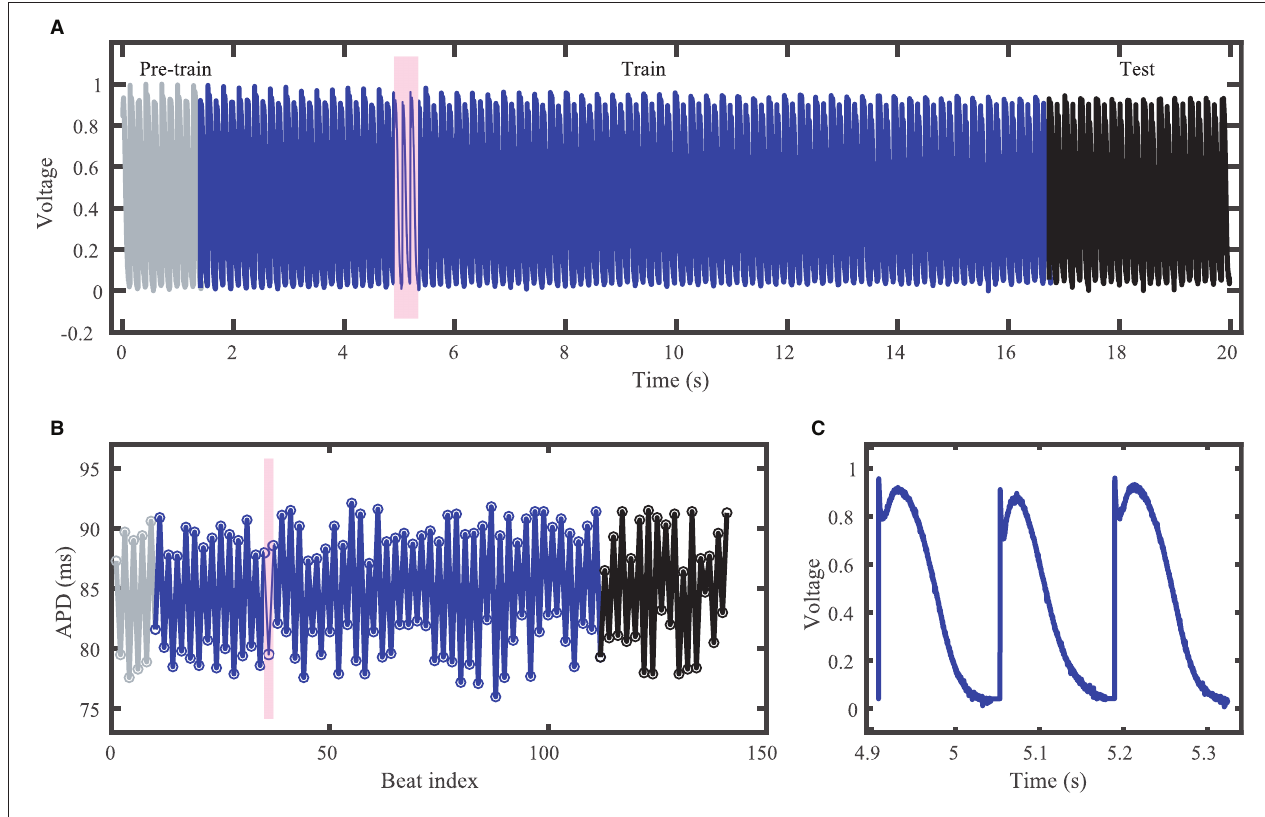
FIGURE 3 | Experimental zebrafish action potential time series featuring irregular alternans characterized by action potentials with irregular cycle lengths and durations. (A) Voltage time series including unused pre-training data (gray), training data (blue), and testing (prediction) data (black). (B) Corresponding APDs, following the same color scheme as (A) . (C) Zoomed in voltage trace corresponding to the shaded region in (A,B) showing the irregular action potential shapes and